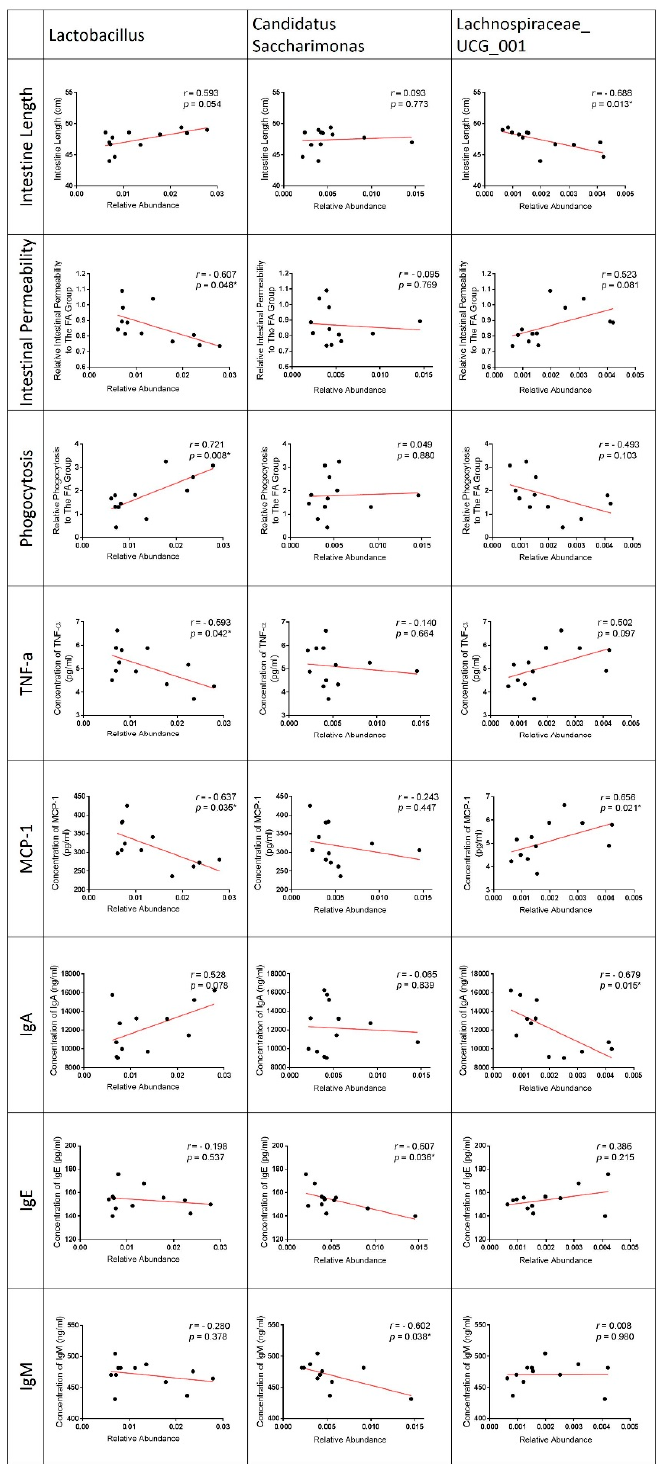
Figure 5. Correlation of Lacticaseibacillus Paracasei PS23 (LPPS23)-modulated bacteria and gastrointestinal (GI) condition. Rank tests with Spearman’s correlation coefficient were used to assess correlations between bacteria ( Lactobacillus , Candidatus_Saccharimonas , and Lachnospiraceae _UCG_ 001) and parameters of intestinal function (intestine length, intestinal permeability, and phagocytosis), pro-inflammatory factors (TNF- α and MCP-1), and immunoglobulin (IgA, IgE, and IgM). Asterisk (*) indicates p < 0.05. n =